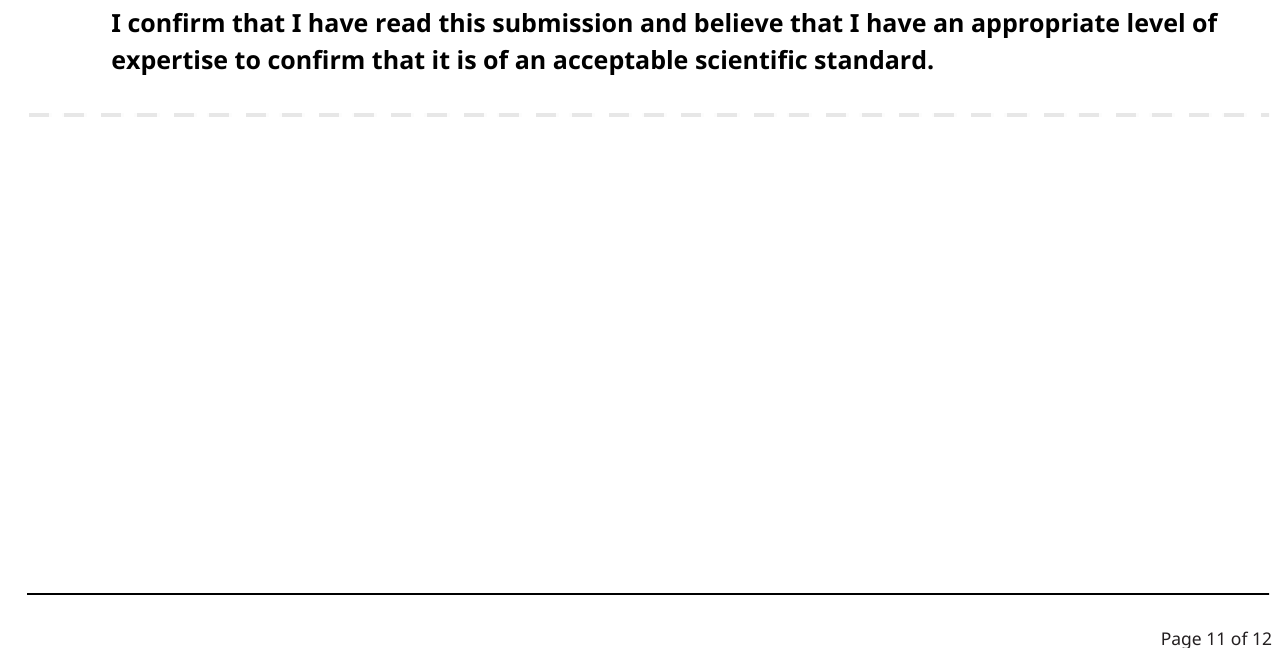
Figure 3. There is autofluorescence from the abdomen. Is this the yolk sac? Please label this. 1. Is there a complication with fluorescent transgenic embryos? I imagine that most lines will not have altered fluorescent eyes but perhaps this can be commented